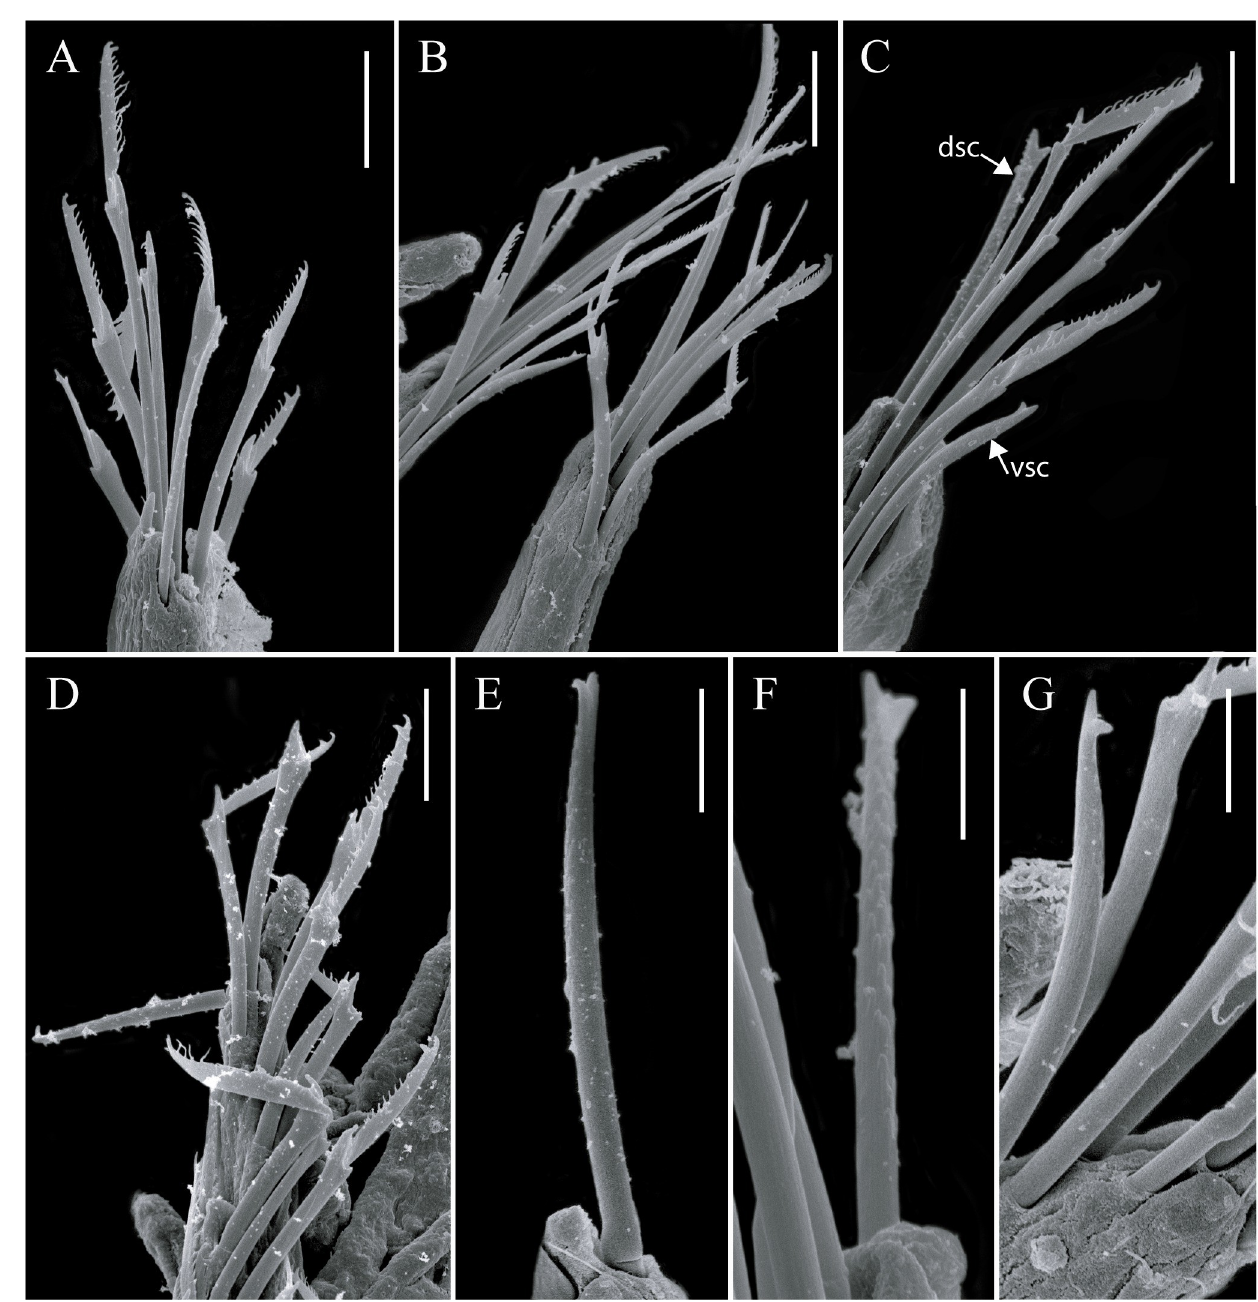
Fig 13. Salvatoria ypsiloides n. sp., SEM. (A–B). Falcigers, anterior and midbody, respectively; (C). Falcigers, dorsal and ventral simple chaetae, midbody; (D). Falcigers, posterior body; (E–F). Dorsal simple chaetae; (G). Ventral simple chaeta, posterior body. Scale bars: A–E, G, 10 μ m; F, 2 μ m. dsc –dorsal simple chaeta; vsc –ventral simple chaeta. slightly longer than the prostomium; antennae and dorsal cirri throughout larger and rather spindle-shaped (although only slightly tapered distally in S . nitidula ); pharyngeal tooth inserted near anterior margin of pharynx; blades of falcigers with narrower angle between teeth than in S . ypsiloides n. sp., and with shorter spinulation in the dorsalmost blades; dorsal